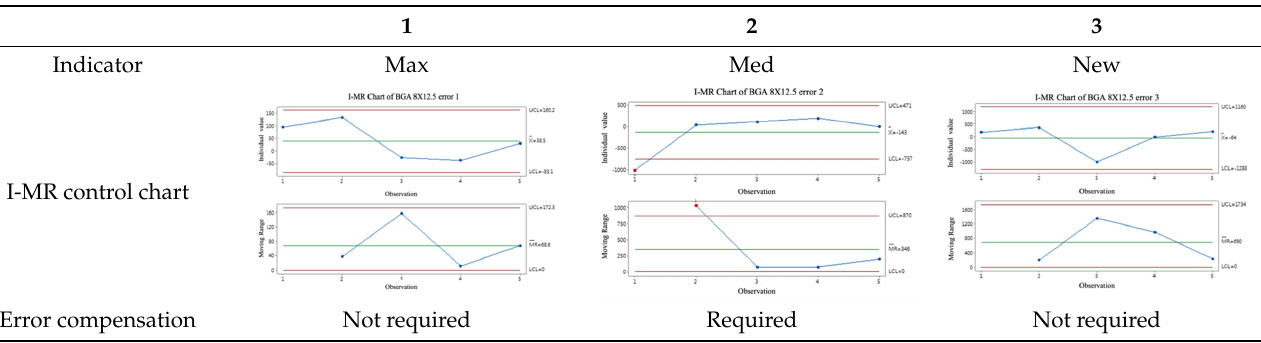
Table 7. BGA 8X13 rolling forecast results summary.